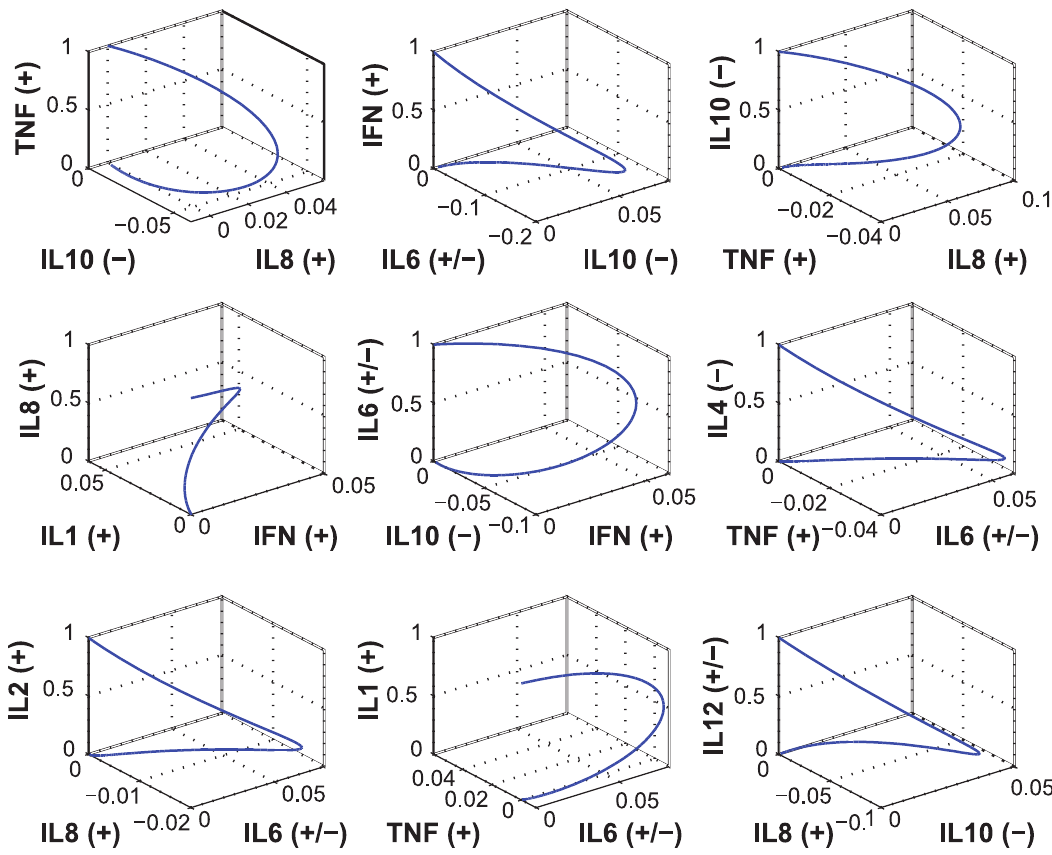
Figure 6. Motifs of response to unit initial cytokine concentrations. doi:10.1371/journal.pone.0045027.g006 cytokine. There are three two-way paths in the figure. TNF- a mutually inhibits both IL4 and IL12, while IL6 enhances and is inhibited by IFN- c . TNF- a , IFN- c , and IL4 are involved in six strong coupling pathways, and IL6 and IL8 participate in seven. The three largest effects of IL1, IL2, and IL8 are inductive; the three largest effects of IL12 are inhibitory.